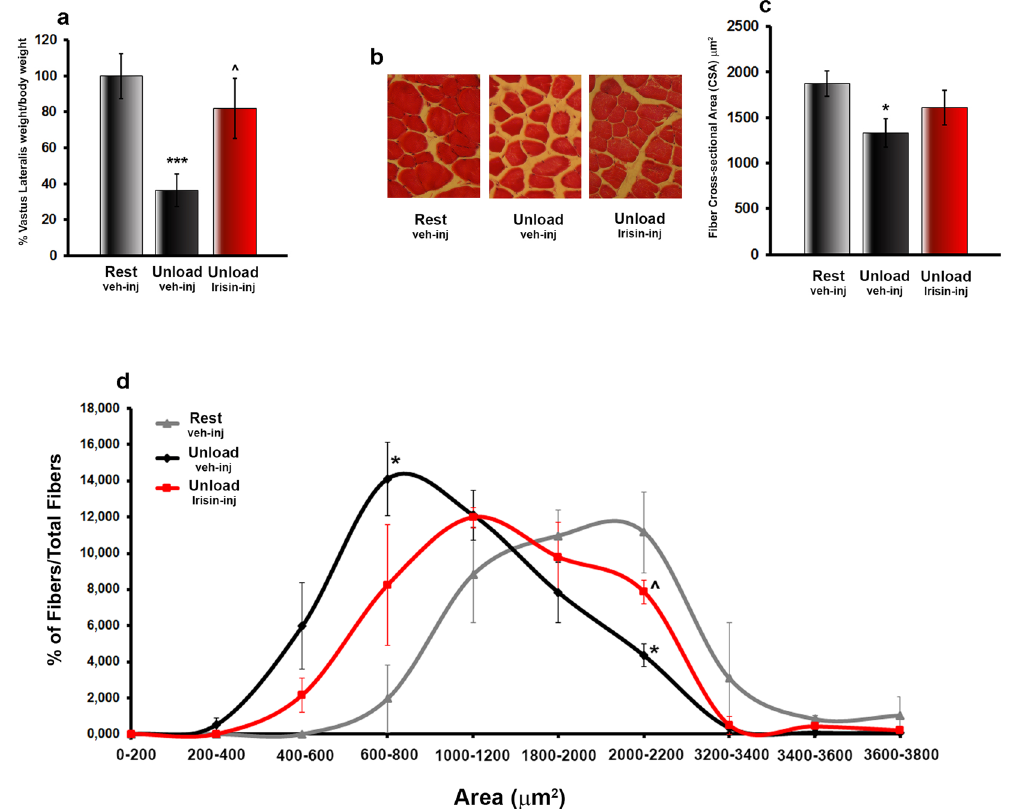
Figure 3. Treatment with r-Irisin prevents muscle wasting in hindlimb-suspended mice. ( a ) Vastus lateralis weight normalized to total body weight from normal loading mice (Rest veh-inj) and unloaded mice treated with vehicle or recombinant Irisin (r-Irisin, 100 µ g kg − 1 per week for 28 days, mice sacrificed 24 hours after last dose). ( b ) Photomicrographs of hematoxylin and eosin stained sections of vastus lateralis from Rest vehicle-injected and Unload vehicle- or Irisin-injected mice (magnification: 20x). ( c ) Quantitative assessments of Cross-Sectional Area (CSA) and ( d ) CSA area distribution of fibers from vastus lateralis harvested from normal loading mice (Rest vehicle-inj) and unloaded mice treated with vehicle or r-Irisin. Data are presented as mean ± SEM. n = 6–7 mice per group. All data were normally distributed according to the Shapiro-Wilk normality test and analyzed by one-way ANOVA and Bonferroni’s post hoc analysis. * p ≤ 0.05, *** p ≤ 0.001 versus Rest vehicle-injected mice. ^ p ≤ 0.05 versus Unload vehicle-injected